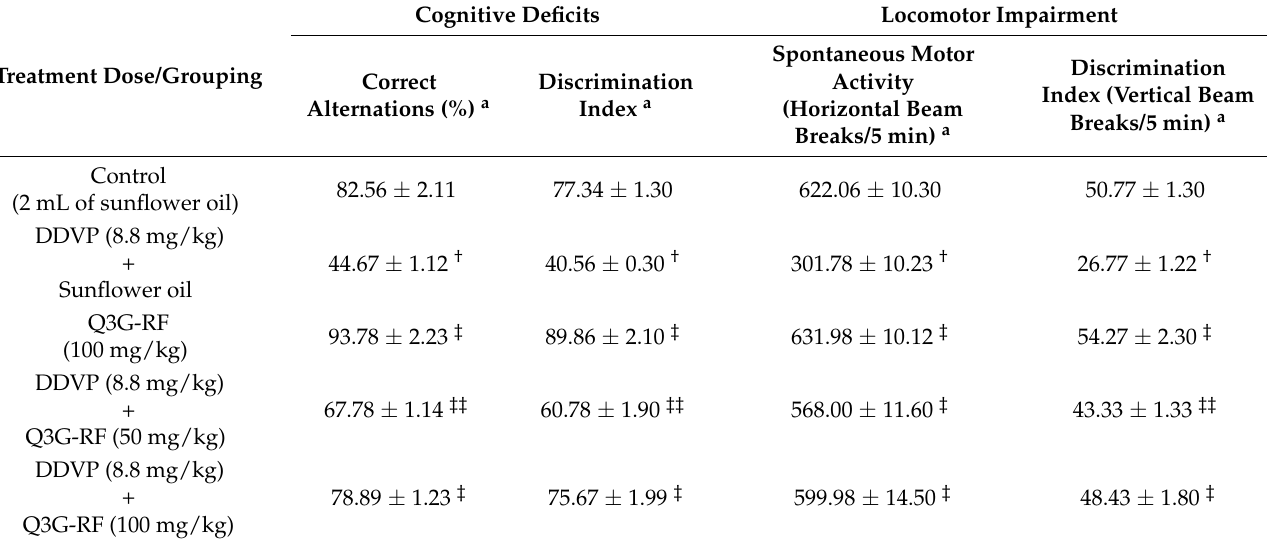
Table 1. Impact of Q3G-RF from S. mombin leaves on cognitive performance and locomotion impair- ment in DDVP-treated female Wistar